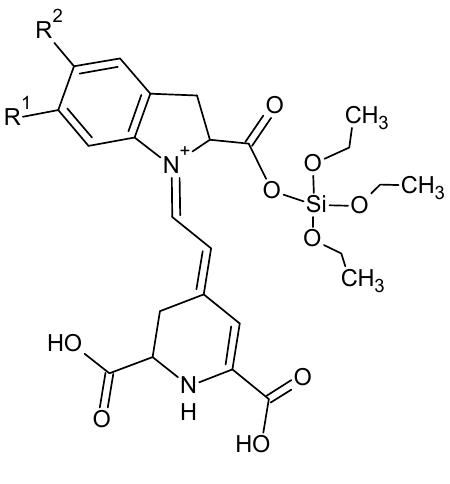
Scheme 1. Graphic representation of the BVE/TEOS